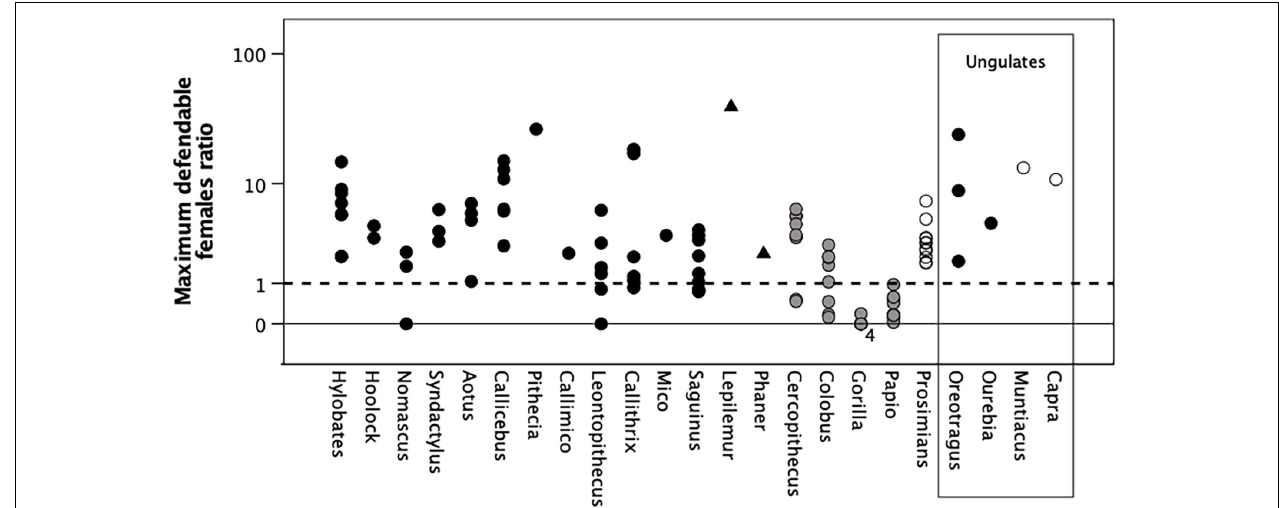
FIGURE 2 | Ratio of maximum number of defendable females, as predicted by the Mitani–Rodman equation, to the default baseline of observed mean number of females per group, for individual populations. The baseline is one female for all monogamous taxa, except Callithrix, Mico , and Saguinus for whom the equivalent baseline is four females (pairbonded females produce twins twice a year) and Callimico and Leontopithecus for whom it is two females (see text). For the polygamous genera, the mean number of females per group is 7.1 for Cercopithecus , 3.8 for Colobus , and 4.4 for Gorilla , 16.5 for Papio, 1.0 for the strepsirrhines, and 3.3 for Capra. When the ratio = 1 (heavy dashed line), the payoffs are equal and males should be ambivalent about their preferred strategy. There are four datapoints at 0 for Gorilla, as indicated by the number just below the line. Filled symbols: social or dispersed monogamous groups; grey symbols: stable polygynous groups; unfilled symbols: roving male polygyny. Ungulate genera are enclosed in the box on the right; all other genera are primates. Y-axis is log 10 scaled. TABLE 1 | One sample t -tests against H 0 = 1 for each of the main indices for each genus for Hypotheses H2 and H3. Genus